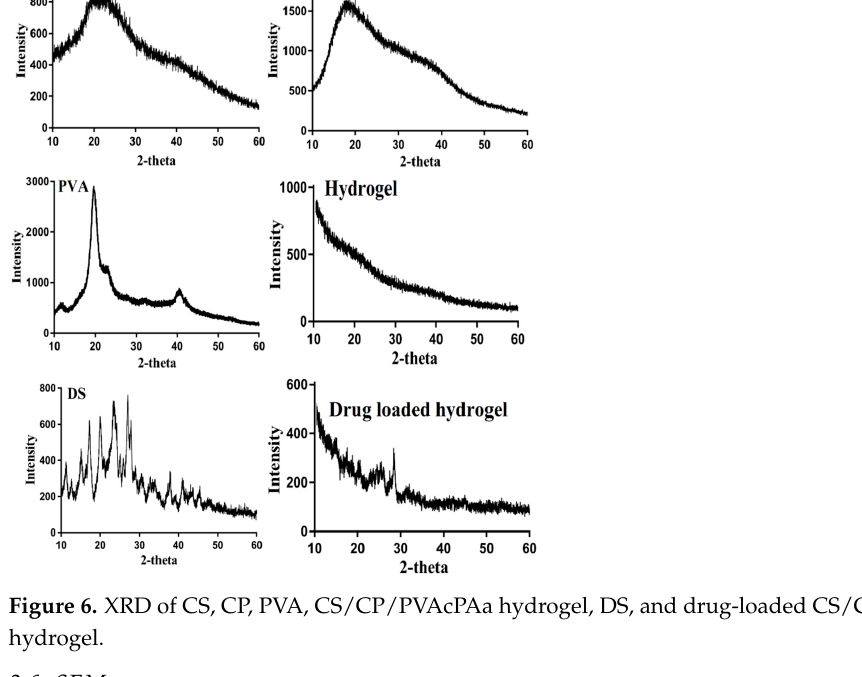
Figure 7. SEM of CS/CP/PVAcPAa hydrogel at different magnifications. 3.7. Sol–Gel Fraction Sol–gel analysis was performed in order to know the soluble uncross ‐ linked and in ‐ soluble crosslinked fraction of prepared hydrogels. Sol fraction, which is the soluble and uncross ‐ linked fraction of the hydrogel, has an inverse relationship with the crosslinked